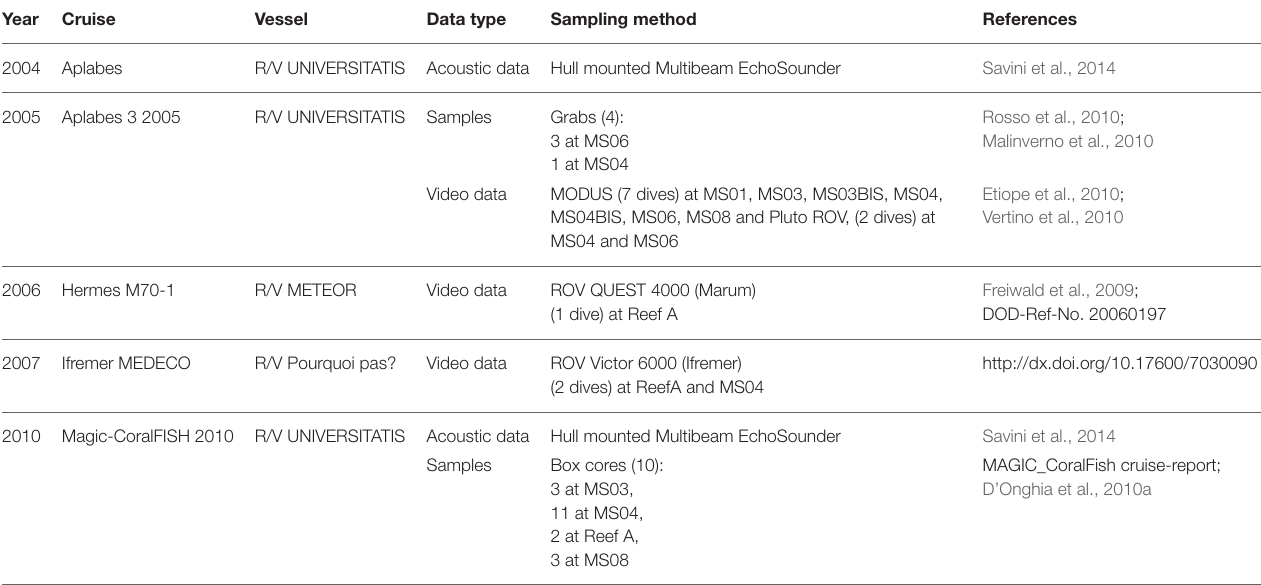
TABLE 1 | List of data used in this study (Multibeam data, Video data,